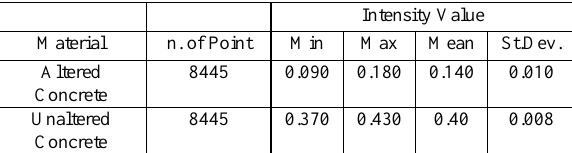
Table 3. statistics of intensity values associated to altered and unaltered surface